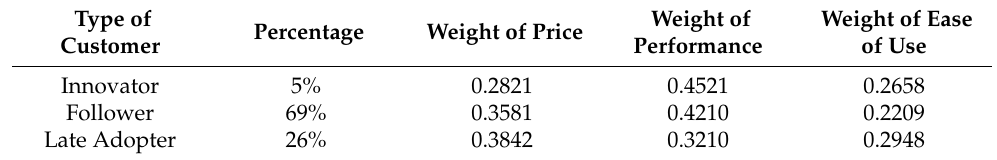
Table 12. Weight of electric vehicle attributes for online ride-hailing drivers.